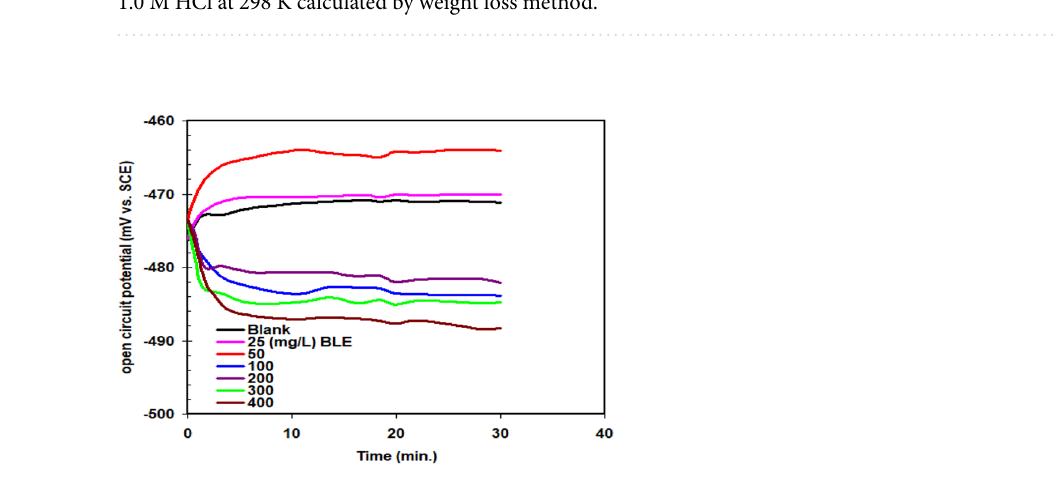
Figure 4. OCP–time curves for X52-steel corrosion in pickling solution (1.0 M HCl) with and without varying concentrations of BLE extract at 298